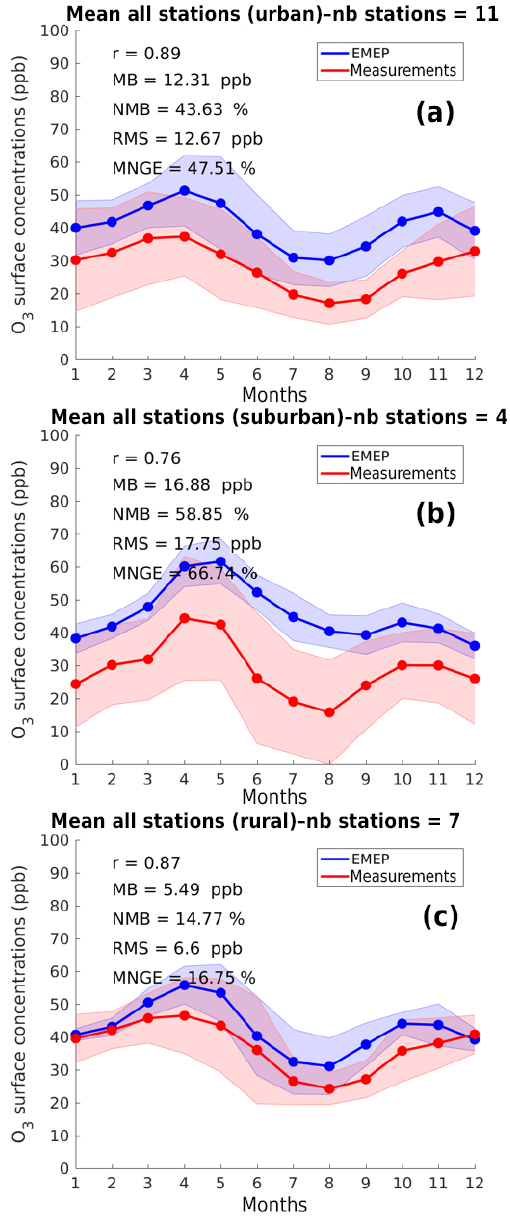
Figure 3. Monthly surface O 3 mean concentrations for the urban (a) , suburban (b) and rural (c) stations shown in Fig. 2 (red) and EMEP (averaged over the period of simulation) (blue). EMEP con- centrations are collocated to each station. The number of stations is given. The shade error corresponds to the standard deviation. The correlation coefficient ( r ), the mean bias (MB), the normalized mean bias (NMB), the root mean square (RMS) error, and the mean normalized gross error (MNGE) are